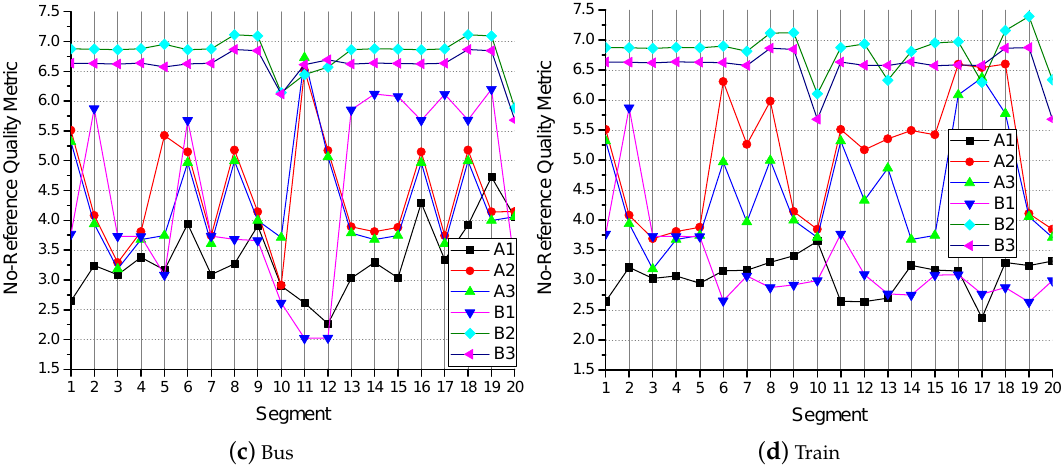
Figure 10. The no-reference quality metric in different network environments.